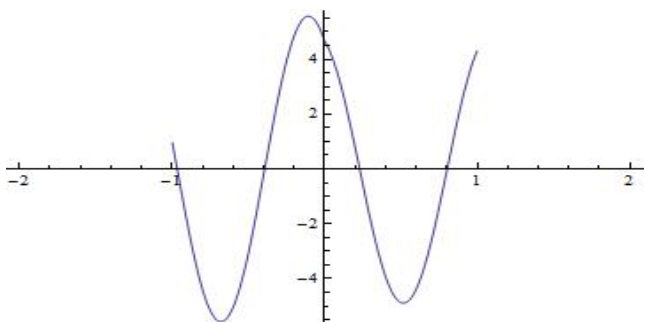
Figure 3. Graph of the first fundamental solution y = φ ( x , λ ) , for λ = 30. (This graph was sketched by using “Mathematica 8”).